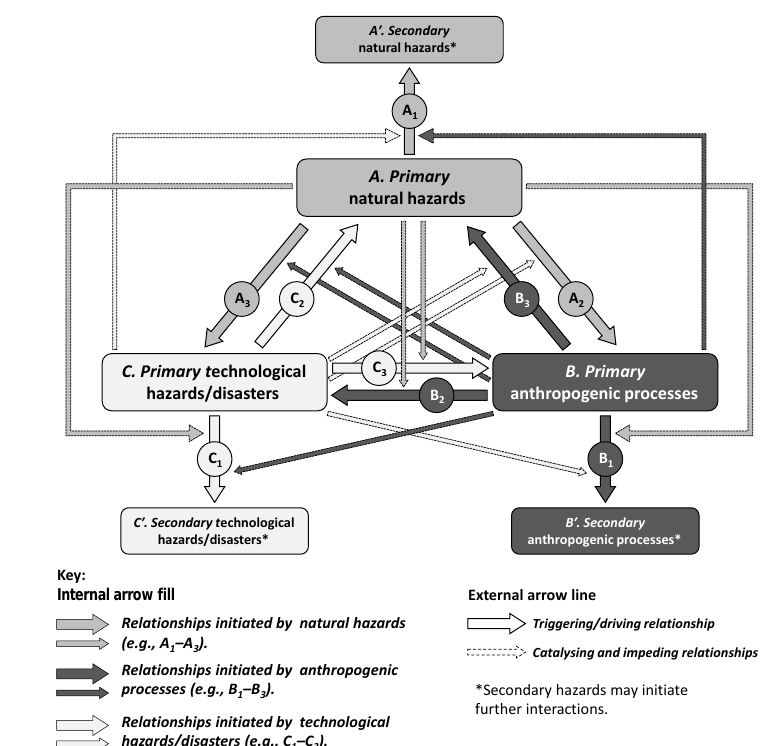
Figure 3. Interaction relationships (triggering, catalysing and impeding) framework using a hazard/process flow diagram. Interactions in the form of triggering relationships (Fig. 2) and catalysing/impedance interactions are possible between (A) natural hazards, (B) anthro- pogenic processes and (C) technological hazards/disasters. We use a prime (A (cid:48) , B (cid:48) , C (cid:48) ) to indicate secondary hazards/processes triggered by the same primary hazard/process group (A, B, C). We contrast here triggering relationships (thick block arrows with solid outlines) and catalysing/impedance relationships (thin block arrows with dashed outlines). The internal arrow fill colour indicates the group of hazards or processes to which the catalyst/impeder belongs (medium grey: natural hazard; dark grey: anthropogenic process; light grey: technolog- ical hazard/disaster). Descriptions of arrow labels (A 1 –A 3 , B 1 –B 3 , C 1 –C 3 ) can be found in the Fig. 2 caption. Examples of catalysing and impedance relationships are given in Sect. 4.4.